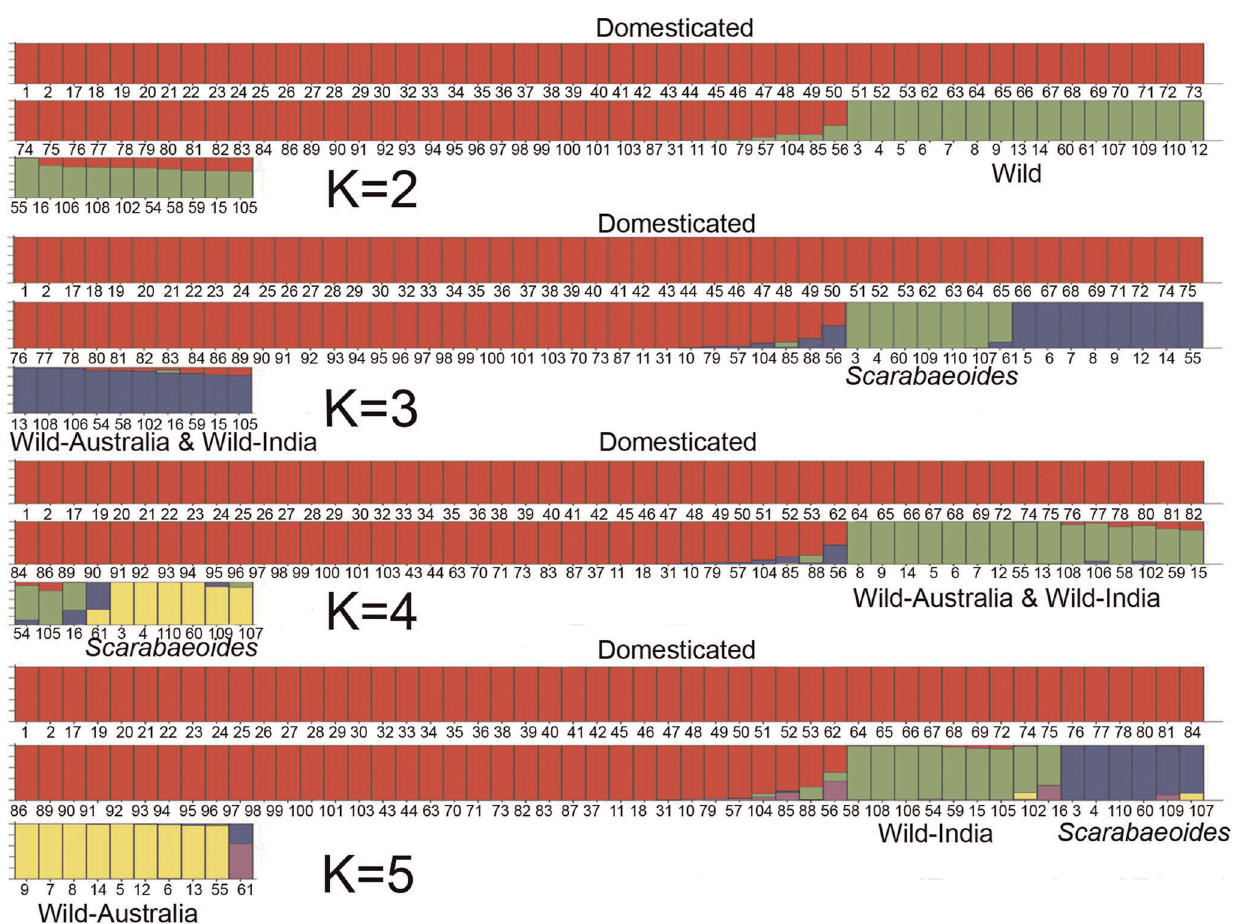
Figure 4. Population structure among the wild and domesticated genotypes of Cajanus . Output of the population genetic program STRUCTURE at increasing K values of 2 to 5. The primary divisions at increasing K values mirror phylogenetic groupings shown in Figures 1 and 2. Memberships of individual genotypes to specific subgroupings are indicated by colored bars. Genetic admixture is evidenced by fractional membership in multiple subgroups. The correspondence between numbers below each genotype and specific accessions is given in Table S1. Likelihood values for each value of K are given in Table S3.